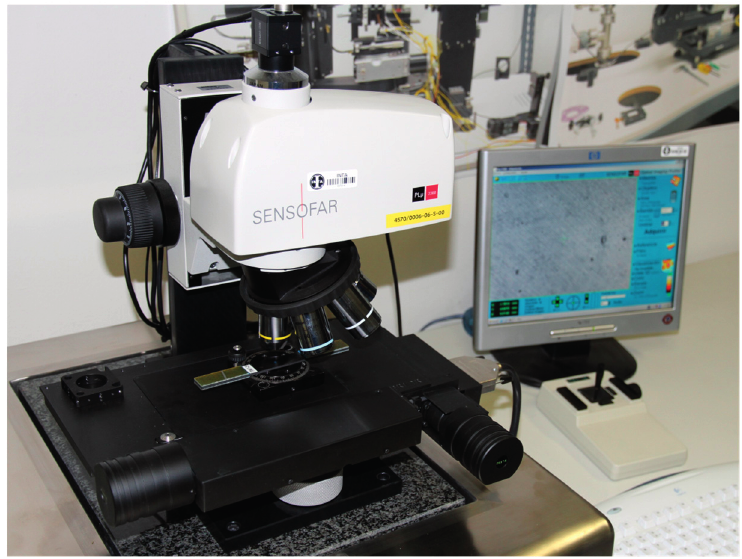
Figure 3. Experimental setup to measure the surface roughness by the confocal microscope.